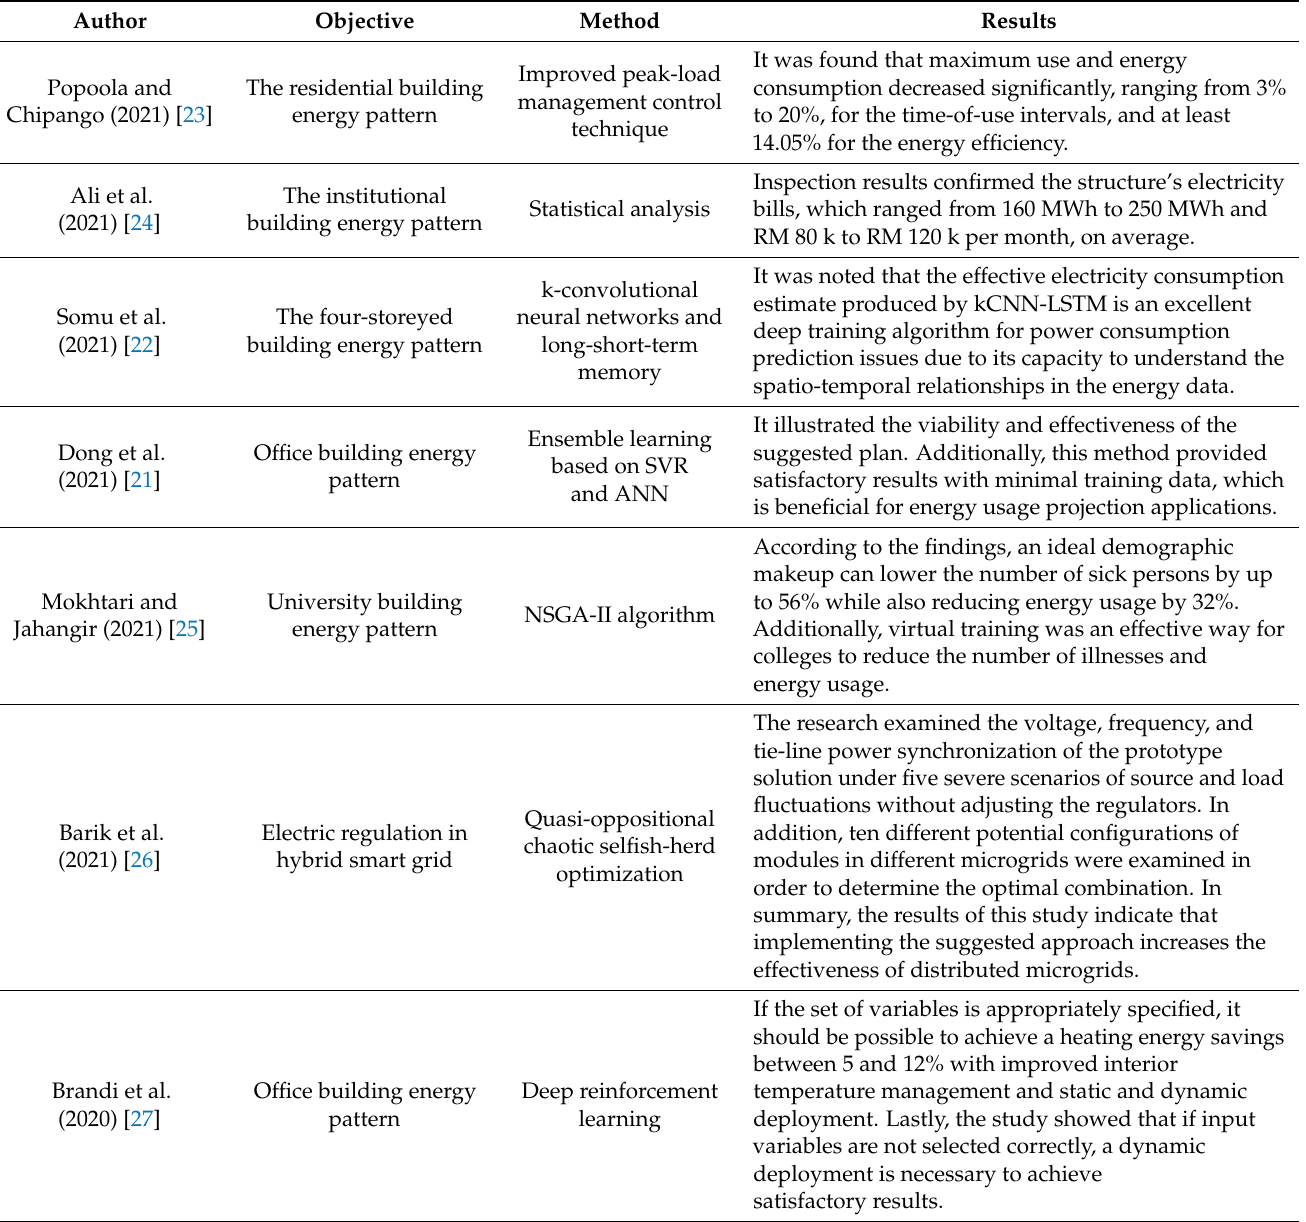
Table 1. A summary of the research in the field of building energy pattern